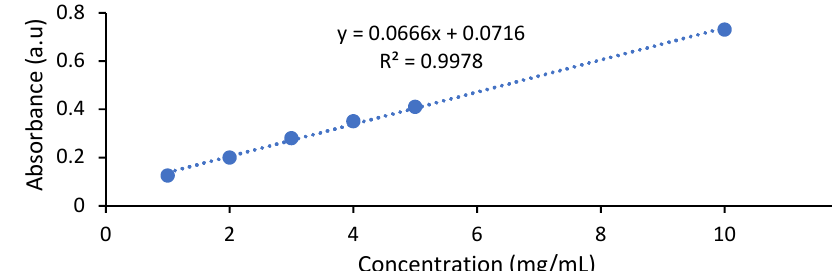
Figure 2. Calibration curve of the extract resulted from peels of red beetroot. Table 1. Characteristics of extract obtained from peels of red beetroot.